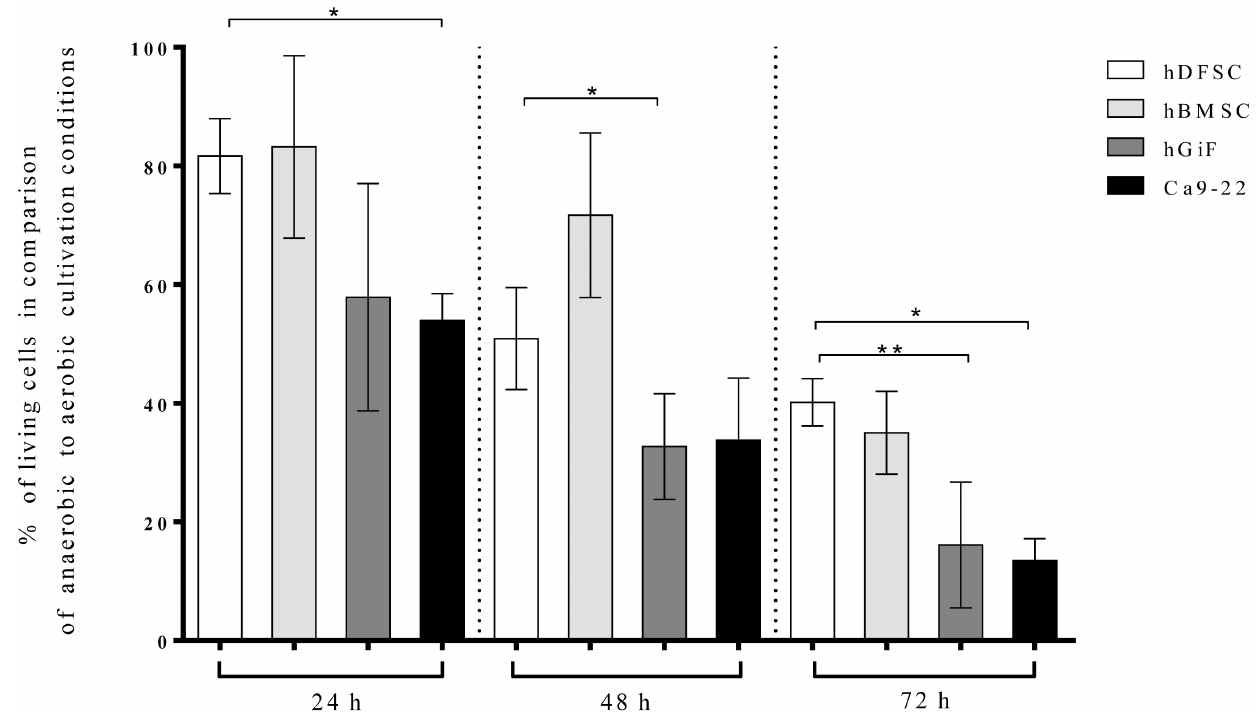
Figure 1. Cell survival under anaerobic conditions. Survival of hDFSC, hBMSC, hGiF and Ca9-22 cells under anaerobic compared with aerobic conditions. Anaerobic atmosphere: (10% CO 2 , 10% H 2 , 80% N 2 ) and 37 u C. Viable cells were counted at timepoints of 24, 48 and 72 h in a Neubauer hemacytometer by exclusion of trypan blue. Values are expressed as means 6 SD (standard deviation), *p , 0.05 (T-test), n=4. Asterisks indicate statistically significant differences between hDFSC and hBMSC, hGiF, and